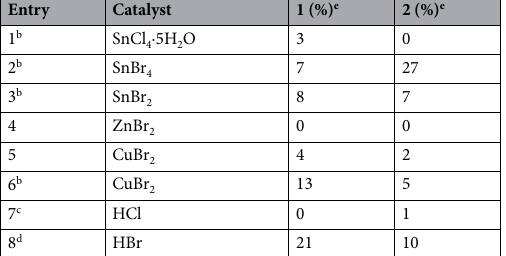
Table 3. Conversion of an authentic starch sample into methyl levulinate ( 1 ) and methyl lactate ( 2 ) using metal catalysts with halogen atom counter anions a . a Reaction conditions: starch (50 mg), methanol (5.0 mL), catalyst (0.024 mmol), naphthalene (0.156 mmol), Ar (5 atm), 24 h, 160 °C. All reactions were performed twice, and the yields of 1 and 2 are average values. b Catalyst (0.24 mmol). c Catalyst (0.048 mmol). d Catalyst (0.96 mmol) in 25% AcOH. e Yields (%) of each product are carbon-based. The amounts of 1 and 2 produced were determined by 1 H NMR